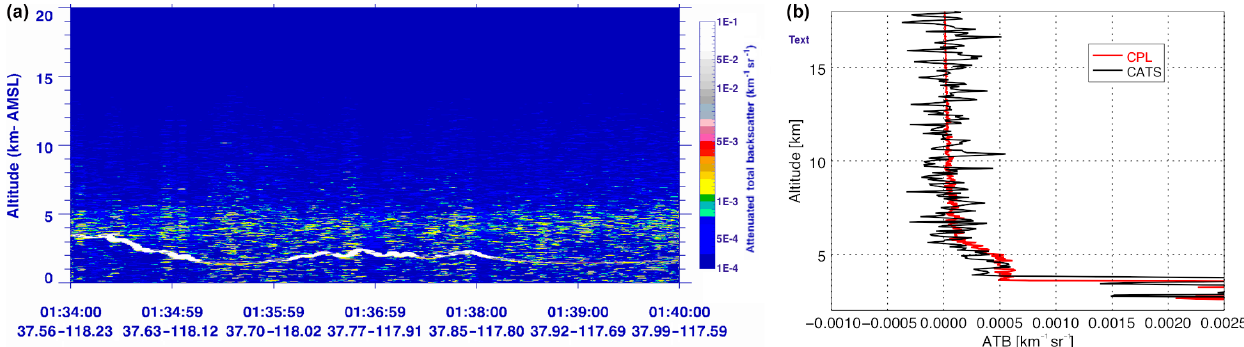
Figure 5. The CPL curtain plot of ATB centered around the 01:37UTC coincident point from the 7 to 8 August 2015 CCAVE flight (a) . The mean ATB profiles from CATS and CPL during this underflight (b) .